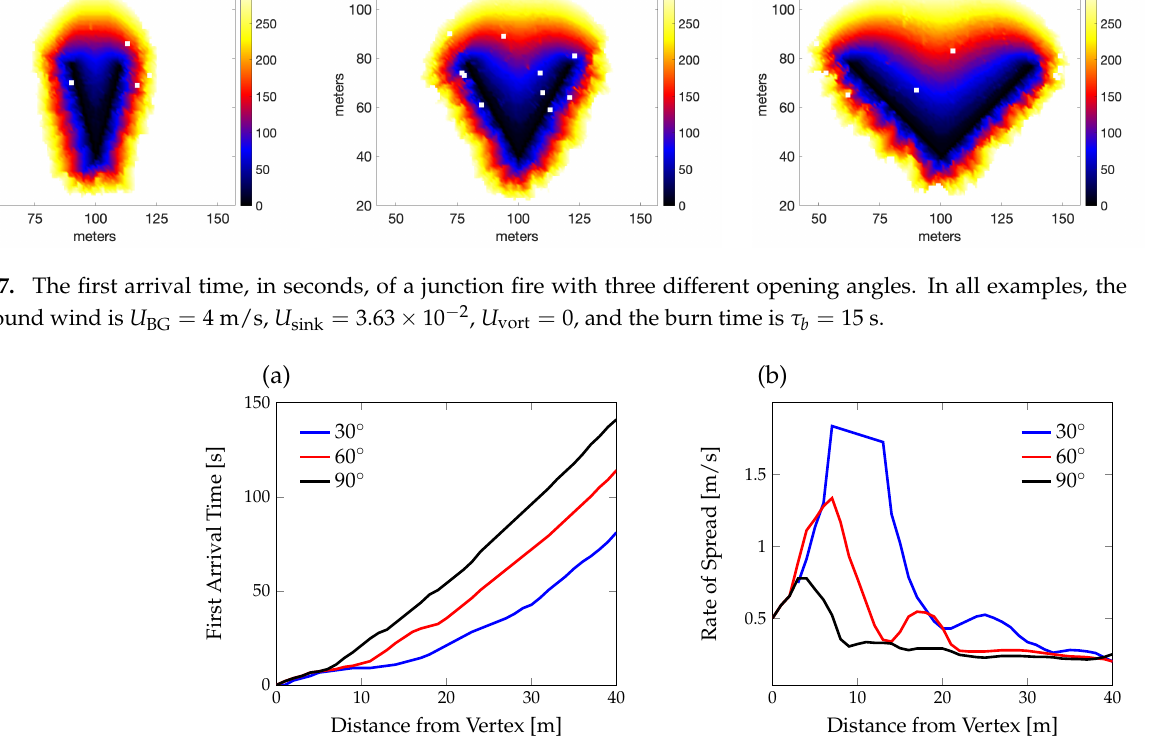
Figure 8. ( a ) The first arrival time at the center line between the two flanks. The x -axis is the distance from the vertex where the two flanks meet. Heat maps are provided in Figure 7. ( b ) The rate of spread, defined using Equation (7), along the vertical line bisecting the ignition